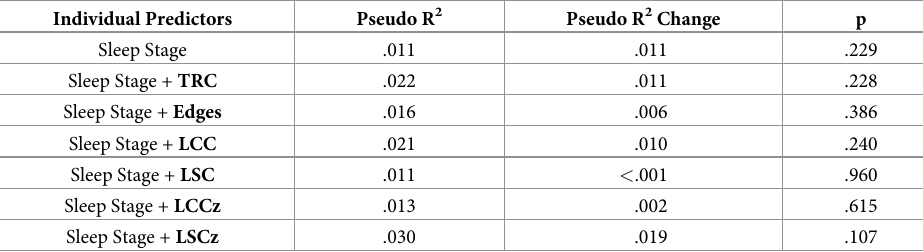
Table 2. Results from generalised linear mixed models in predicting time of